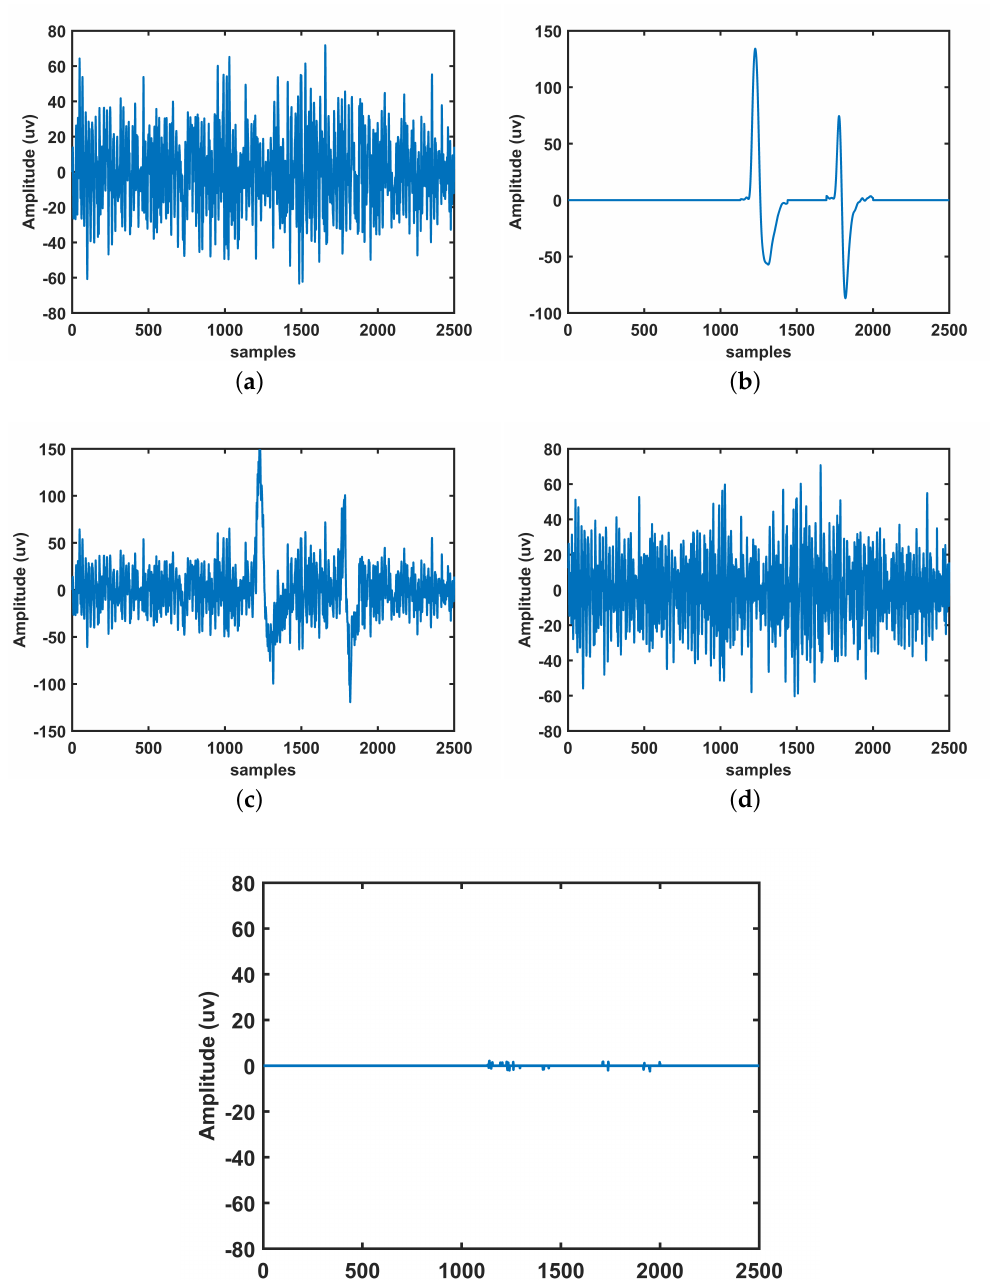
Figure 5. EOG removal in synthetic EEG data using proposed method. ( a ) Ground truth EEG signal. ( b ) Synthetic EOG artifact. ( c ) Contaminated EEG with EOG. ( d ) Filtered EEG using proposed method. ( e ) Variance signal by subtract filtered signal from original